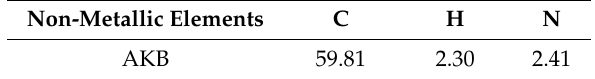
Table 2. Some non-metallic elements of AKB obtained by elemental analyzer (mass,